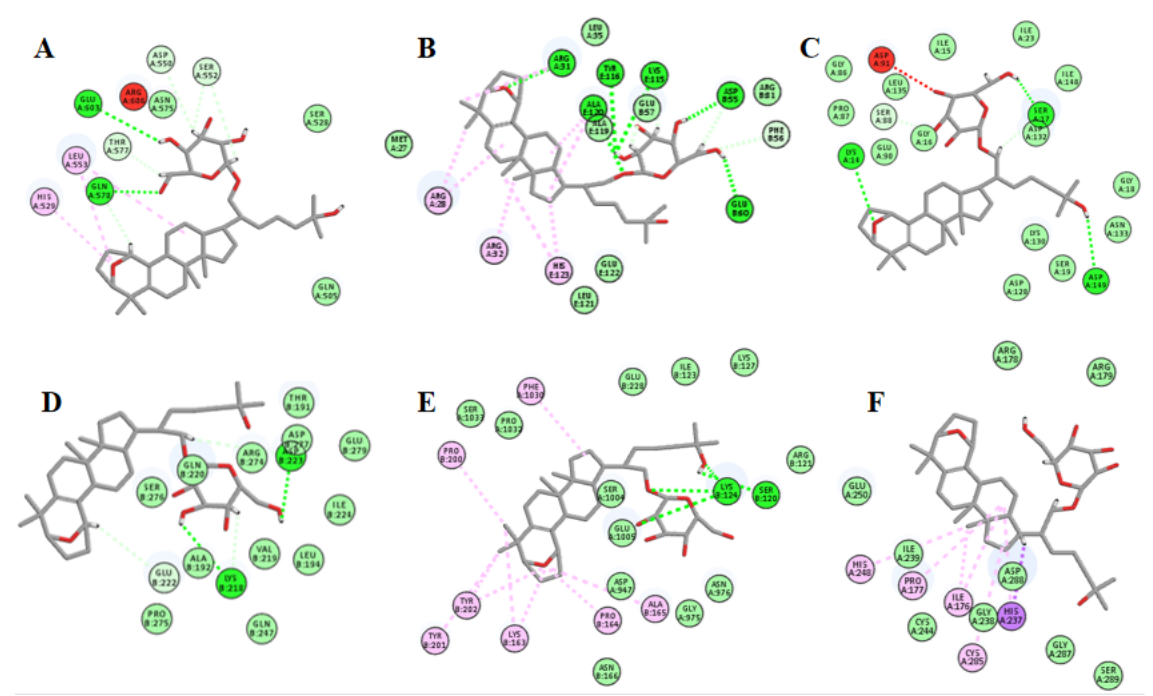
Figure 12. Chemical structure of Gyp I.